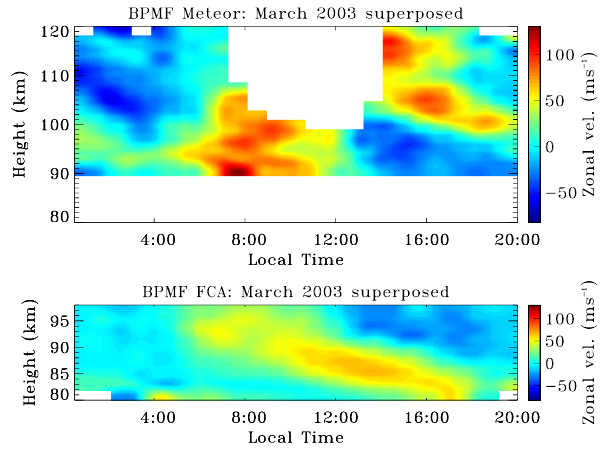
Fig. 10. Relative velocity magnitudes for various analyses with re- spect to ”FCA-large”. The red and blue bars denote the range of ratios for the zonal and meridional components,